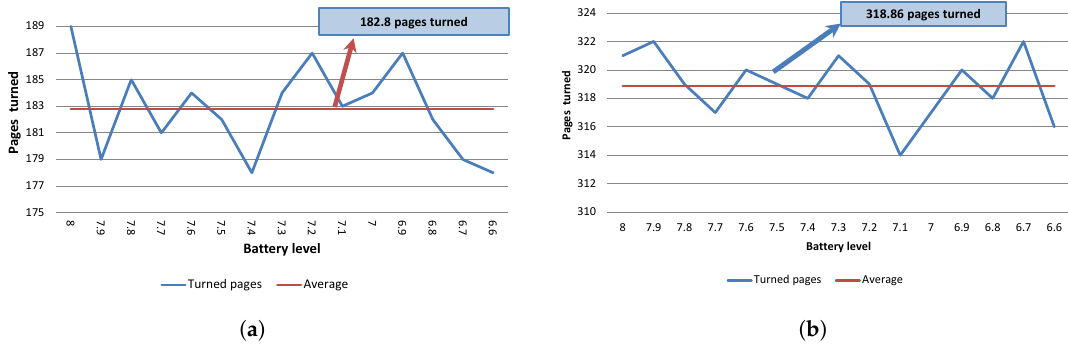
Figure 7. Battery consumption for 65 gr/m 2 pages. ( a ) Battery usage with the thin wheel model and glossy pages; ( b ) Battery usage with the thick wheel model and non-glossy